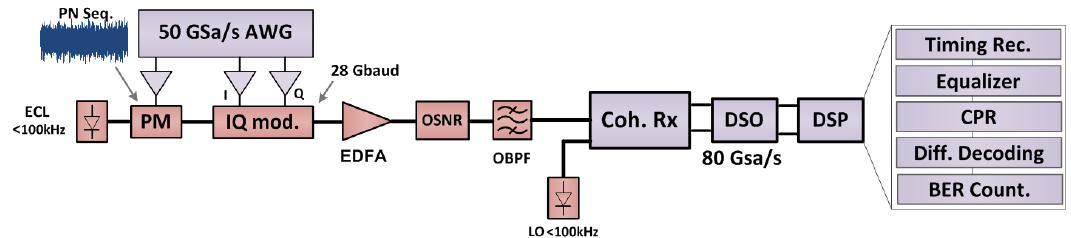
Figure 6. Experimental setup. ECL: External Cavity Laser; PM: Phase Modulator; AWG: Arbitrary Waveform Generator; OBPF: Optical band pass filter; LO: Local Oscillator; DSO: Digital Storage Oscilloscope.